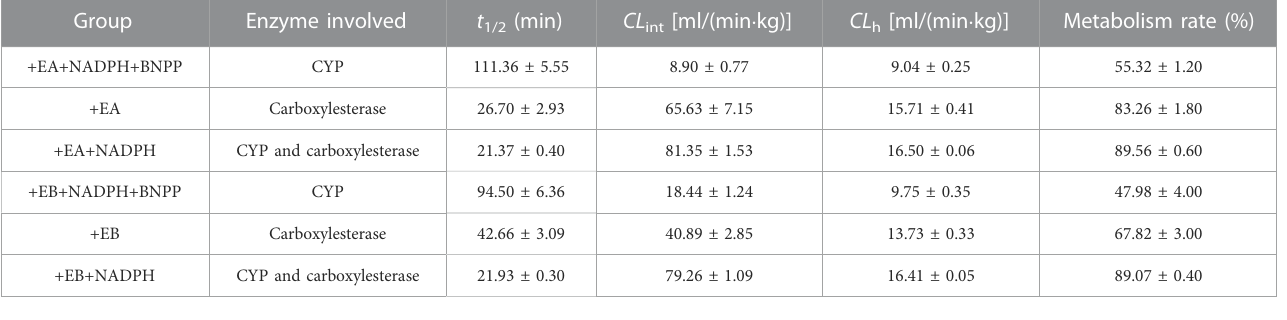
TABLE 1 Metabolic clearance parameters of EA and EB incubated with HLMs in the absence or presence of NADPH, or inhibitor of carboxylesterase BNPP (mean ± SD; n = 3). Group